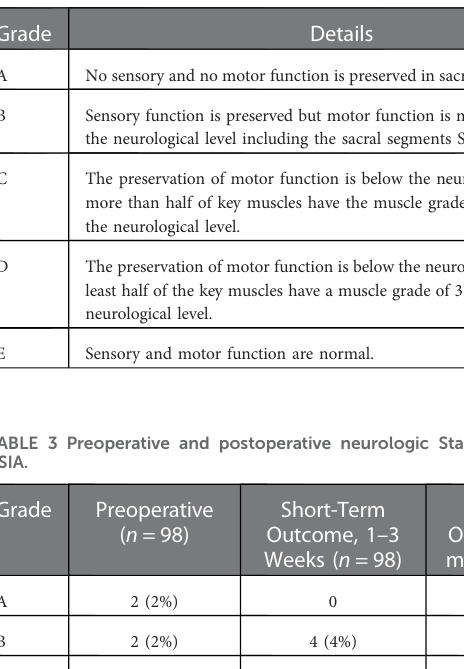
TABLE 2 American spinal injury association (ASIA) impairment scale.